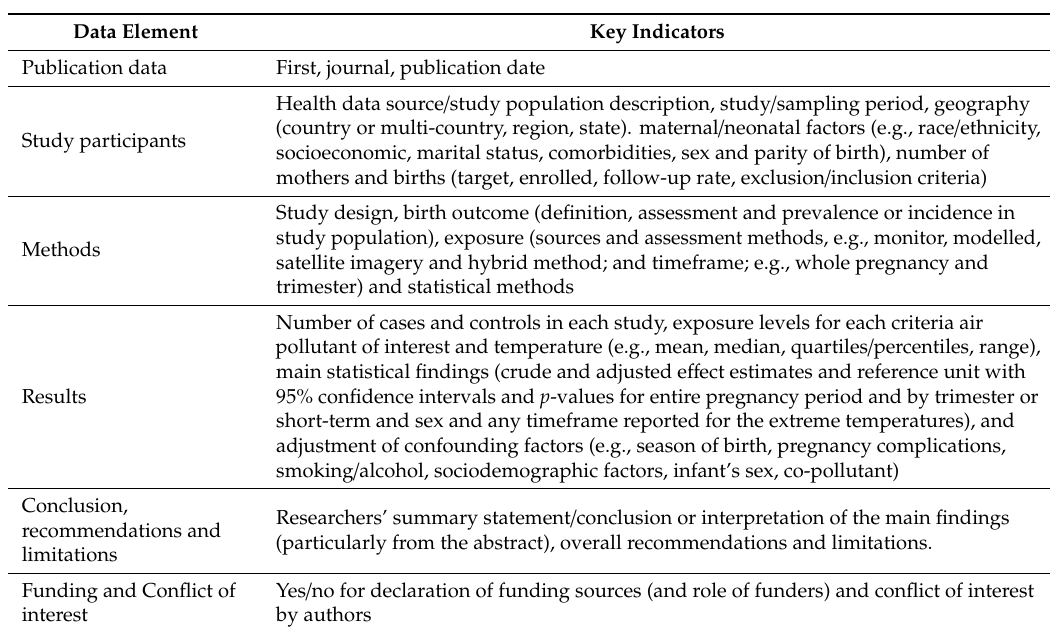
Table 2. Key data extraction elements for Systematic Review 2 (systematic review and meta-analysis in